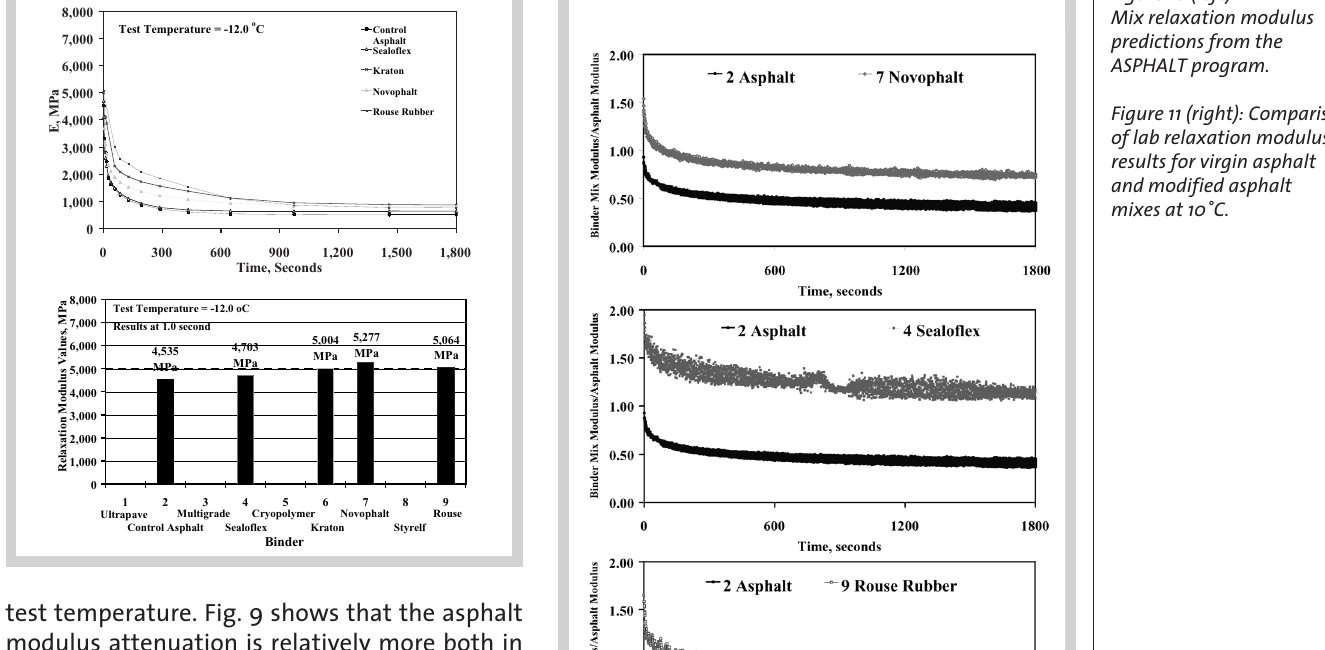
Figure 10 (left): Mix relaxation modulus predictions from the ASPHALT program. Figure 11 (right): Comparison of lab relaxation modulus results for virgin asphalt and modified asphalt mixes at